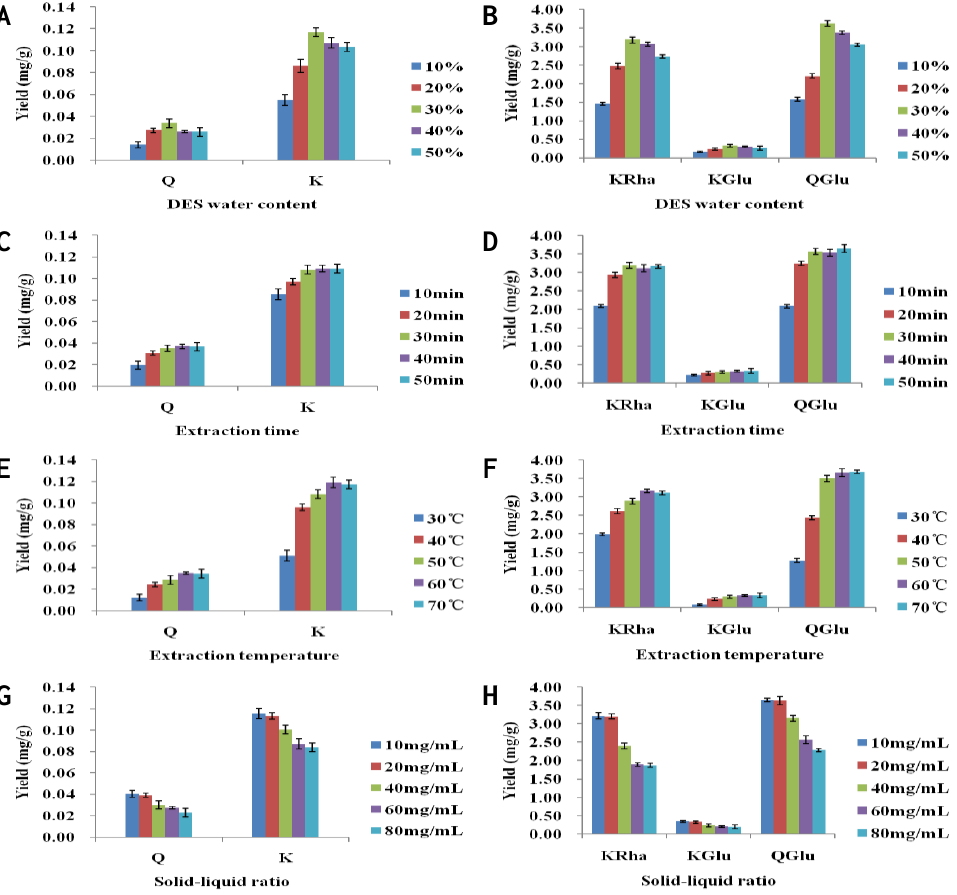
Figure 1. The effect of the water content in the DES, extraction time, temperature, and the solid–liquid ratio on the extraction yield: ( A , B ) water content in the DES, ( C , D ) extraction time, ( E , F ) extraction temperature, and ( G , H ) solid–liquid